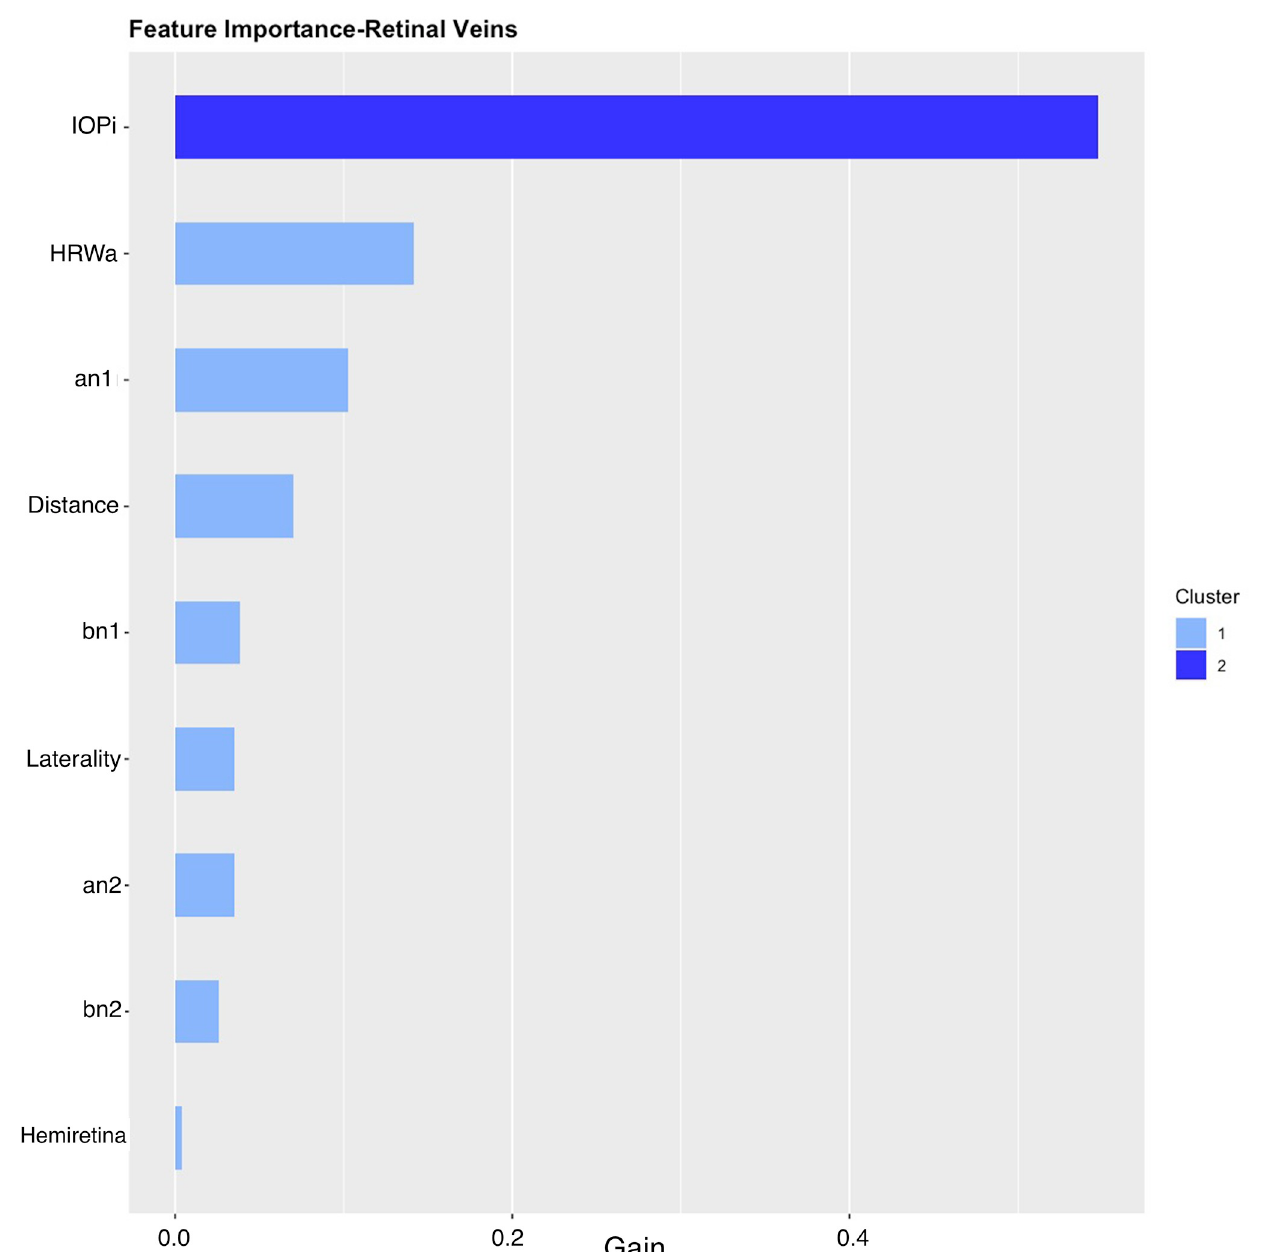
Fig 8. Importance plot retinal venous model. IOP i , HRW a , and a n1 were the most important features in this model. IOP i = Induced intraocular pressure, HRW a =Harmonic regression wave amplitude, a n1,2 = the cosine coefficient of the first and second harmonics, b n1,2 = the sine coefficient of the first and second harmonics, laterality = left / right eye, Distance = distance along the retinal vessel measured in mm, hemiretina = superior / inferior